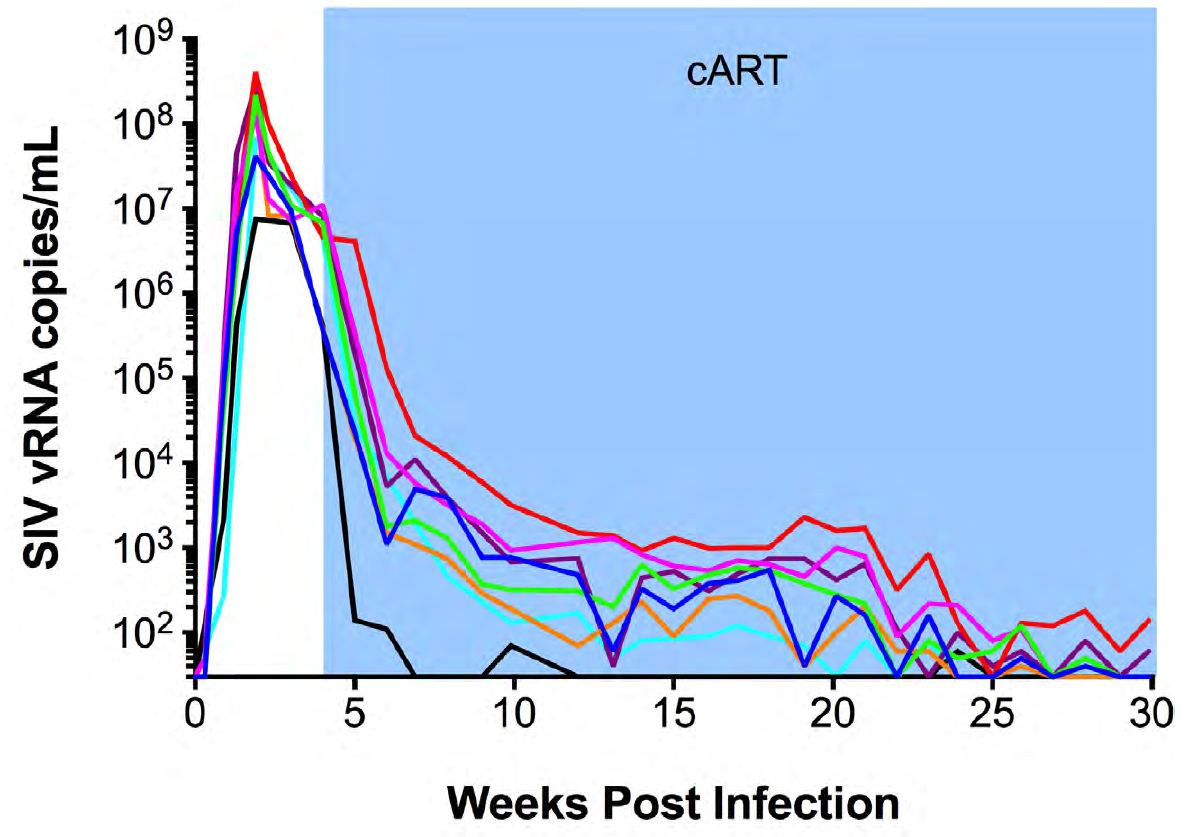
Supplemental Figure 3. Plasma viral load measures from SIV-infected RMs. Eight rhesus macaques (RMs) were infected with SIVmac239 and placed on combination antiretroviral therapy (cART) after 4 weeks post infection (wpi) and followed for an additional 26 weeks (30